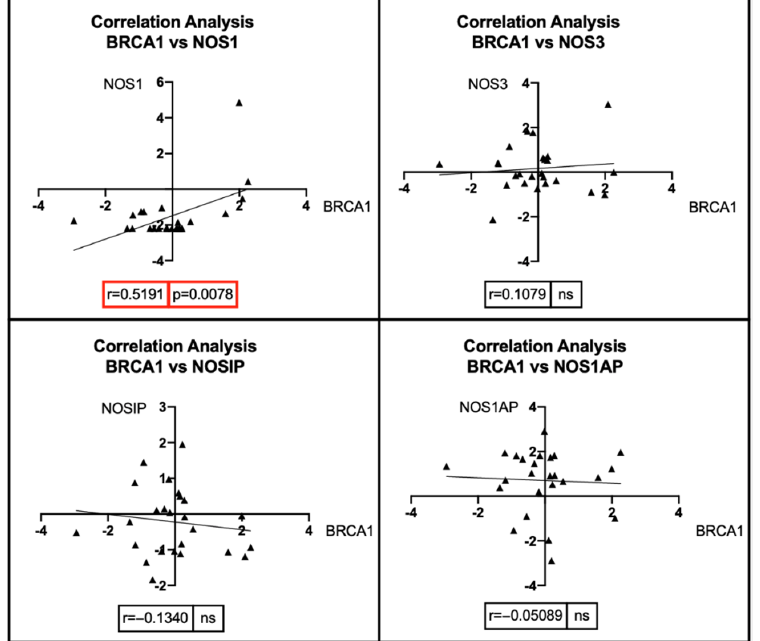
Figure 7. Correlation analyses between the expression levels of BRCA1 and NOS genes in TCGA breast cancer patients with mutations affecting BRCA1 . Each black triangle represents a cancer